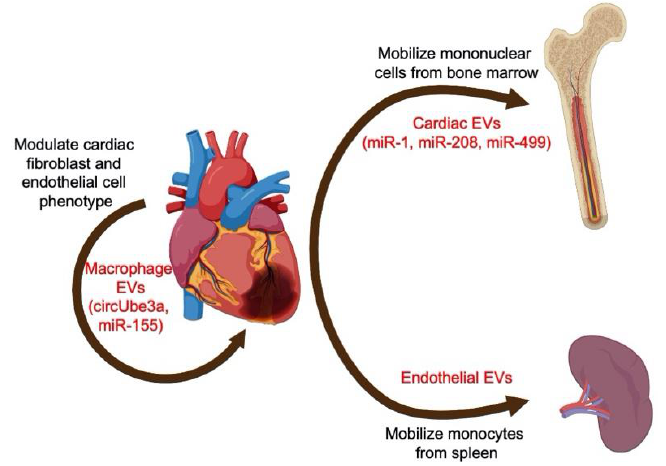
Figure 3. The role of EVs and inflammation in myocardial infarction. Crosstalk between cardio- myocytes and local and peripheral inflammatory cells.